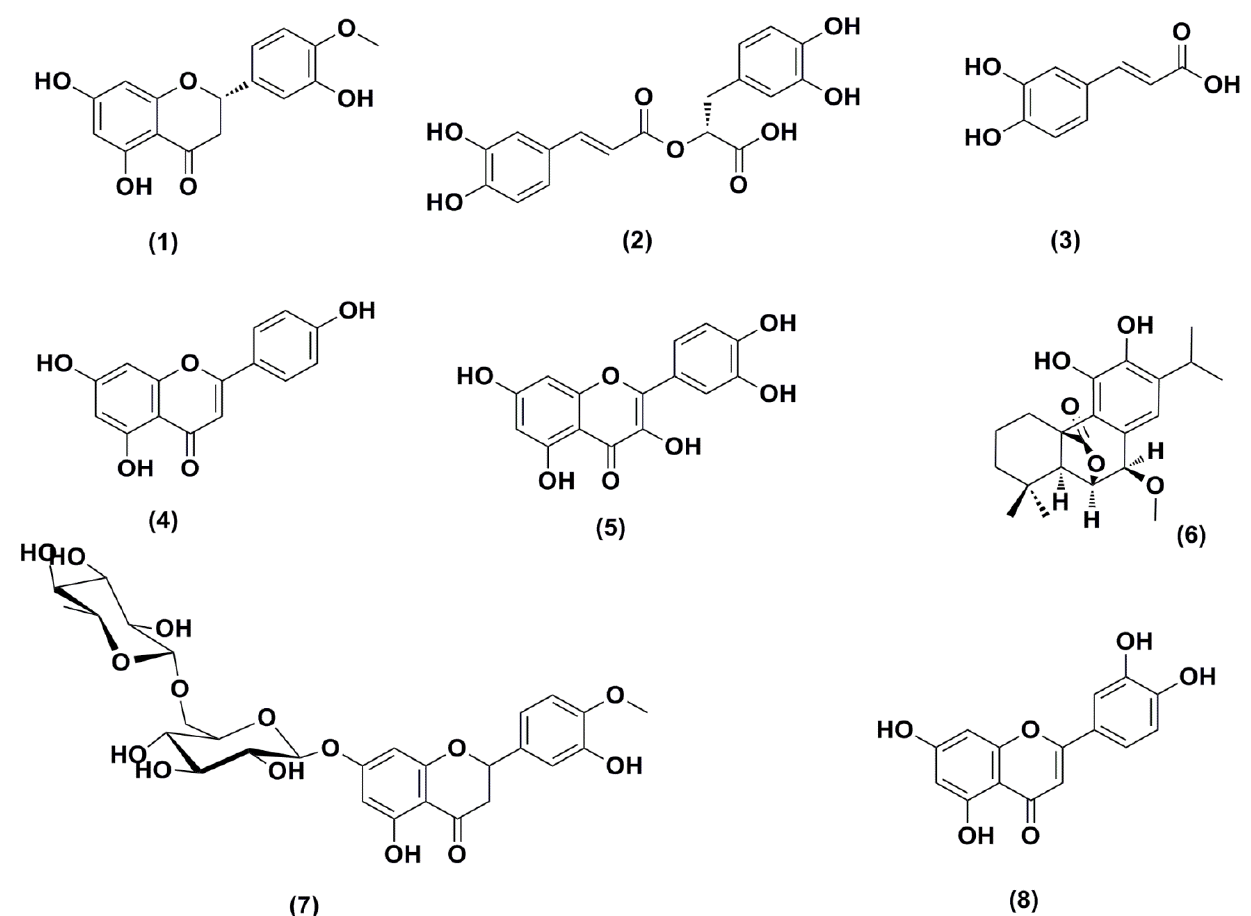
Figure 1. Structures of high features of compounds (ranked by peak intensity) detected in hydromethanolic extract of OM after dereplication of their metabolomes.